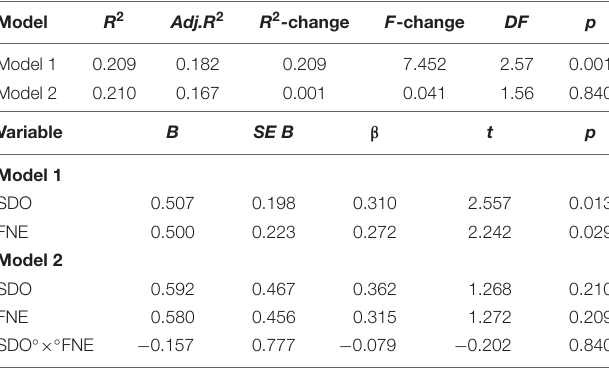
TABLE 1 | Significant predictors of social conformity in hierarchical multiple regressions ( N =